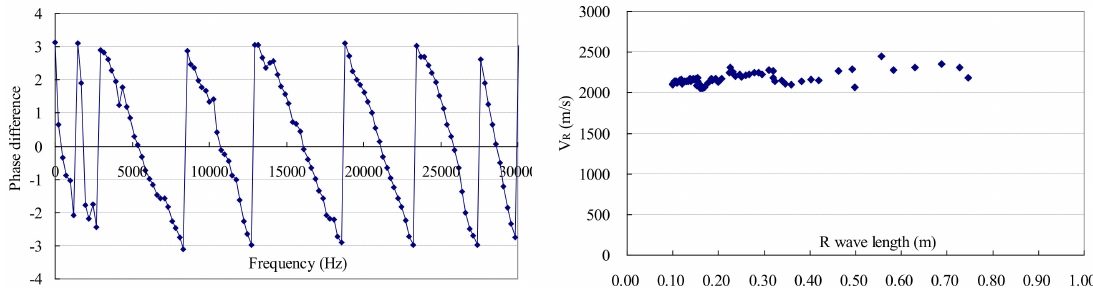
Figure 17. Phase spectrum and dispersion curve at the left sidewall test station at section 12+250.